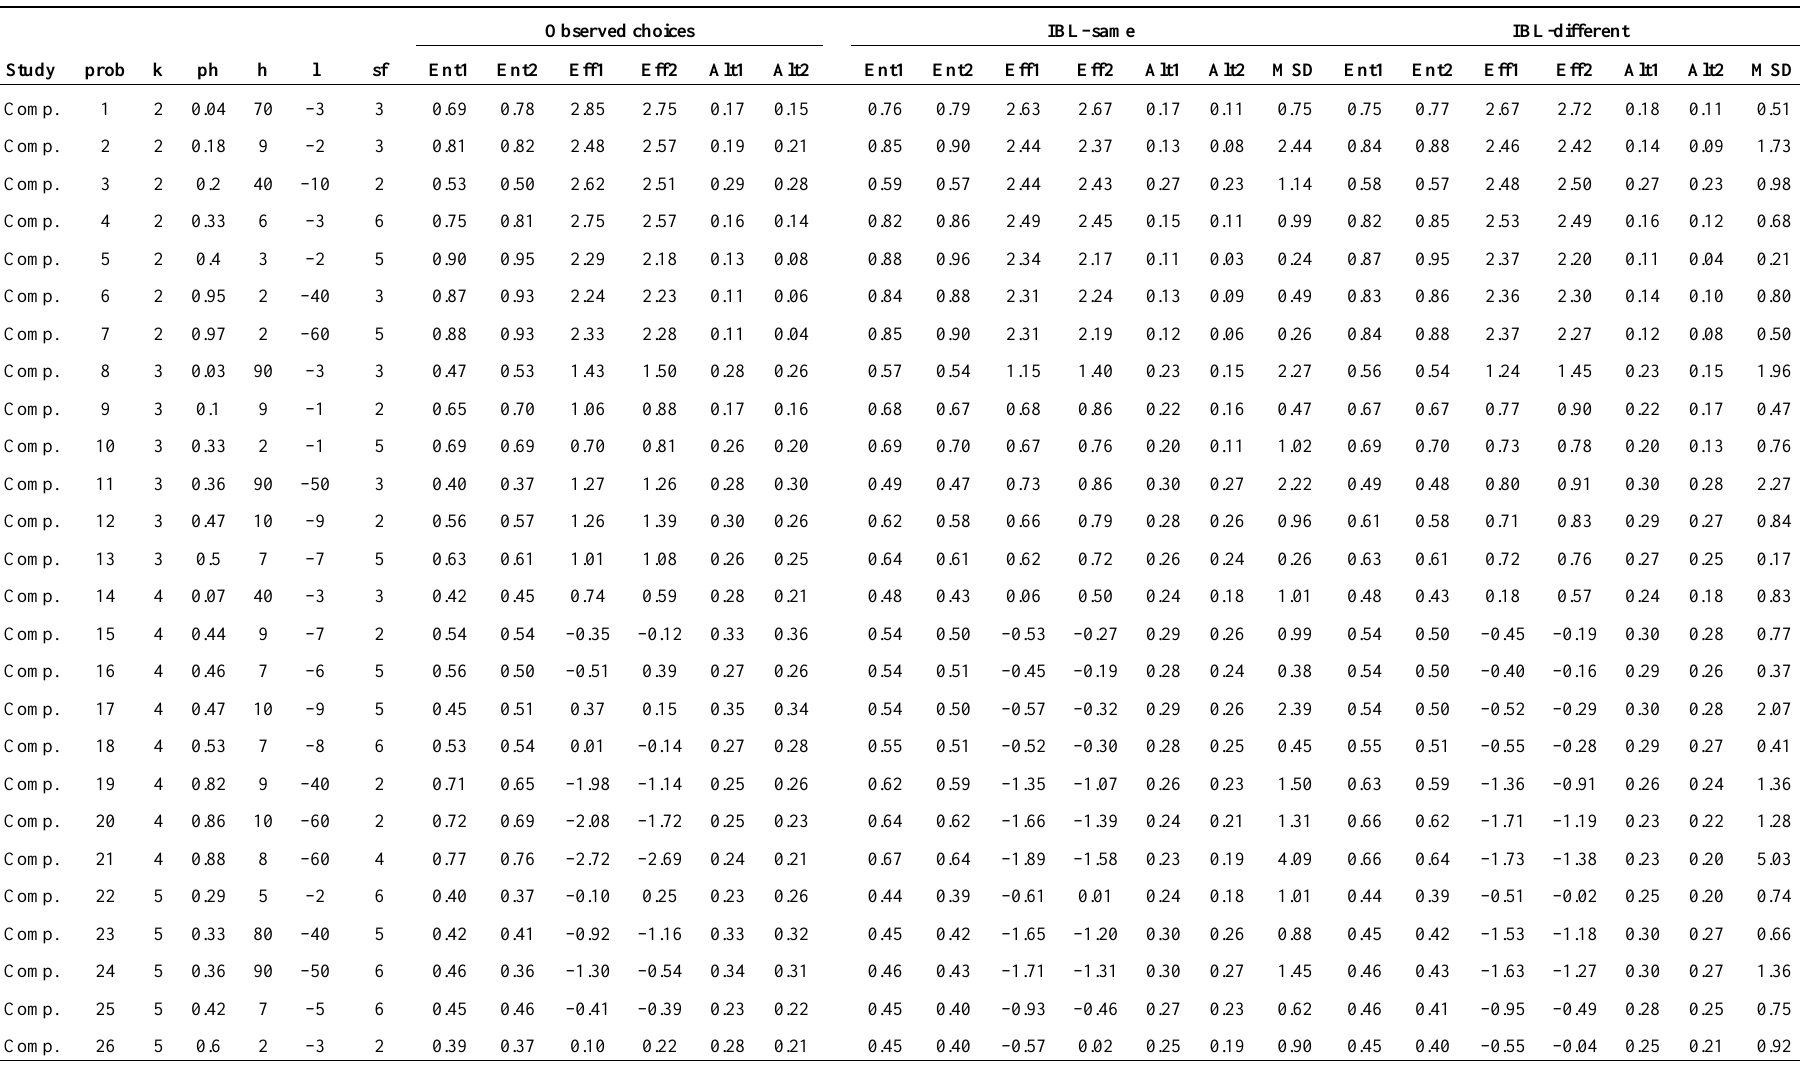
Table A2. The 40 market entry games in the competition set. Problem parameters, observed choice rates, and predictions by the IBL-same and